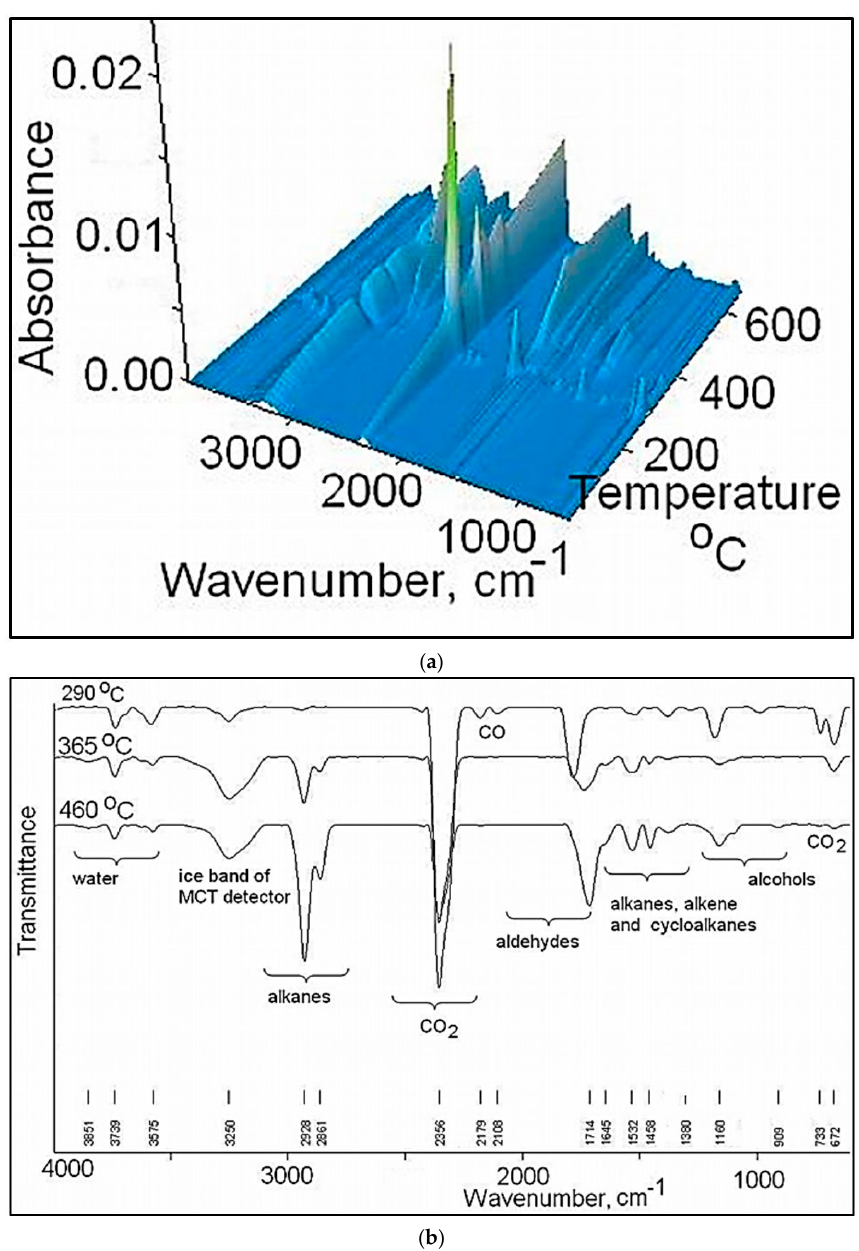
Figure 9. Stacked plot diagram ( a ) and FTIR spectra of the evolved gases at 290, 365, and 460 ◦ C ( b ) for EBSA